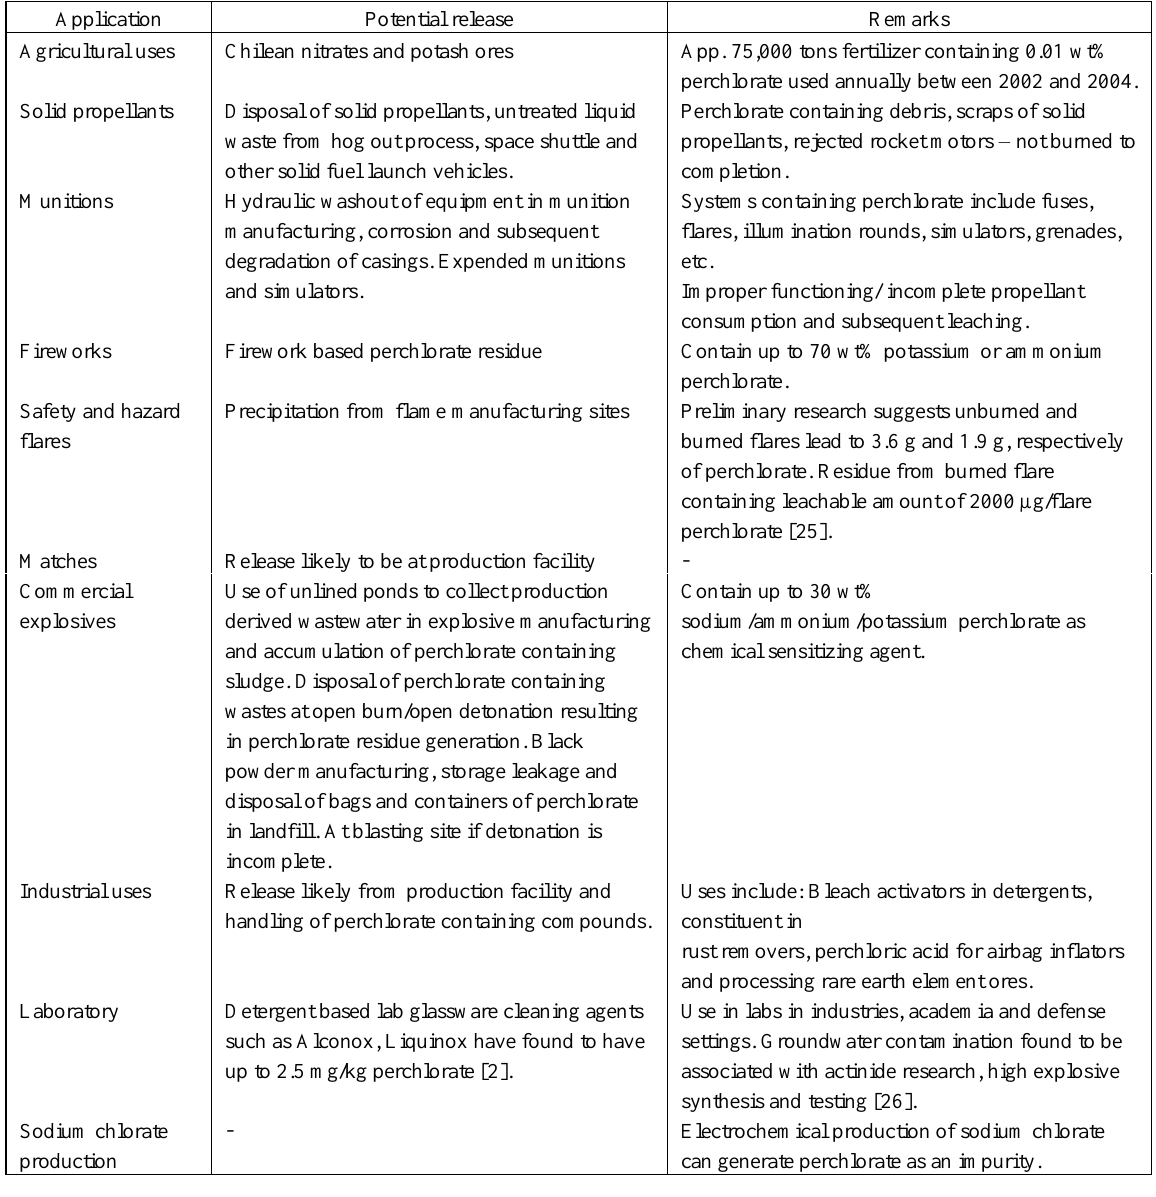
Table 2. Releases of perchlorate compounds